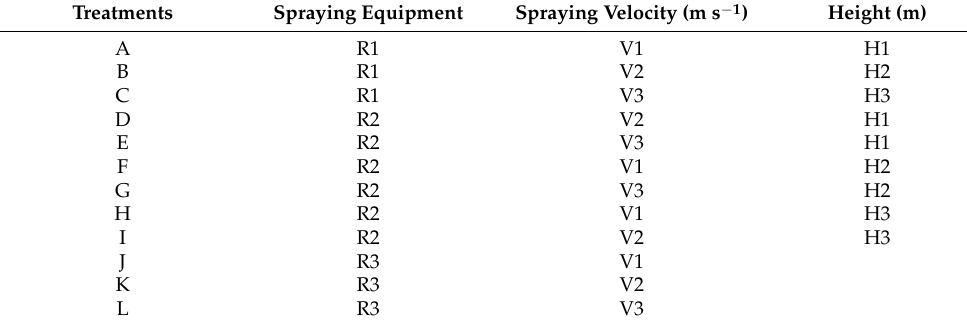
Table 3. Orthogonal experimental